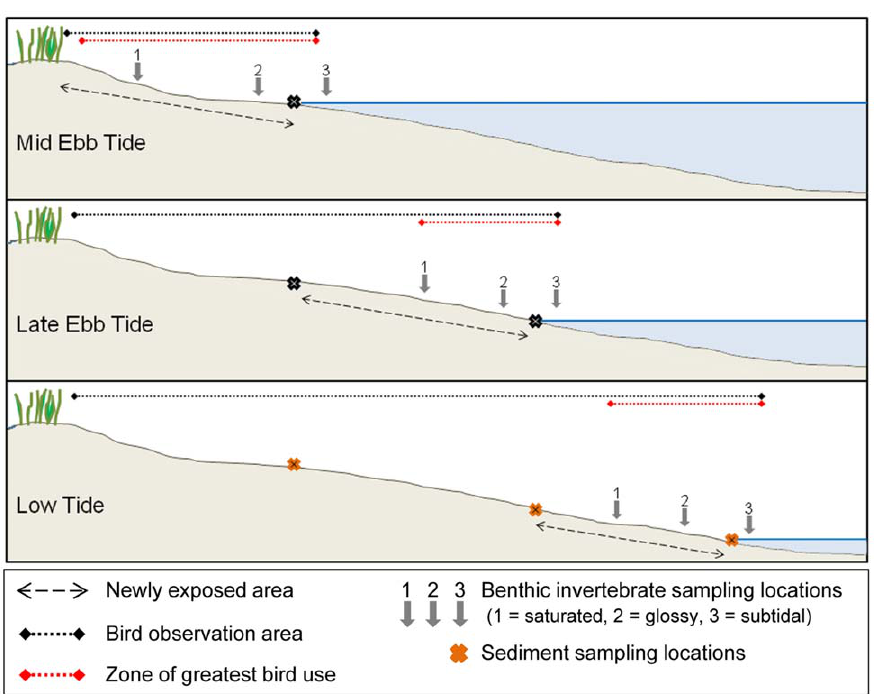
Figure 2. Sand flat sampling schematic. Sediment samples from all flats and all tidal heights were taken at low tide. The relative position of where the sediment samples would be taken subsequently is indicated by the darker crosses in each of the diagrams showing earlier tidal stages.